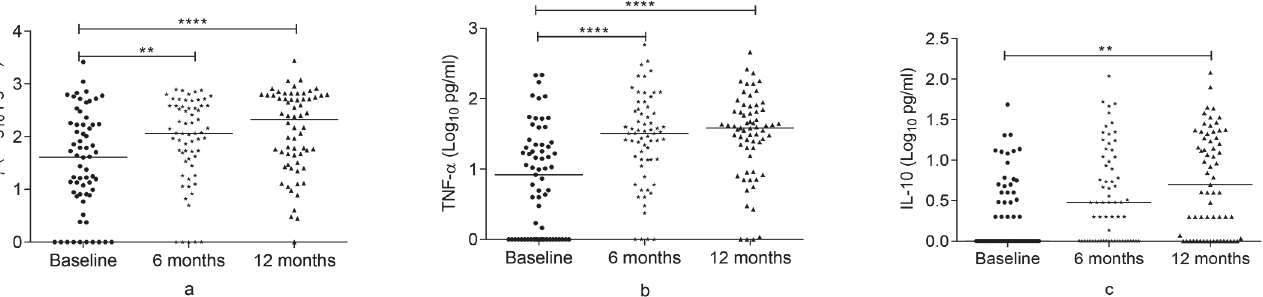
Fig 11. Changes in cytokine responses to E6C10 over 12 months in contacts. IFN- γ (a), TNF- α (b) and IL-10 (c) responses to E6C10 in contacts at baseline, 6 and 12 months following whole blood stimulation with E6C10 for 48 hours. Filled circles represent baseline levels, filled diamonds represent 6 month levels and filled triangles represent 12 month levels. Results are individual responses and cytokine levels are expressed as log 10 pg/ml. Horizontal bars are medians. Freidman test with Dunn ’ s multiple comparisons was used to compare cytokine levels overtime. ** p < 0.01, **** p < 0.0001.